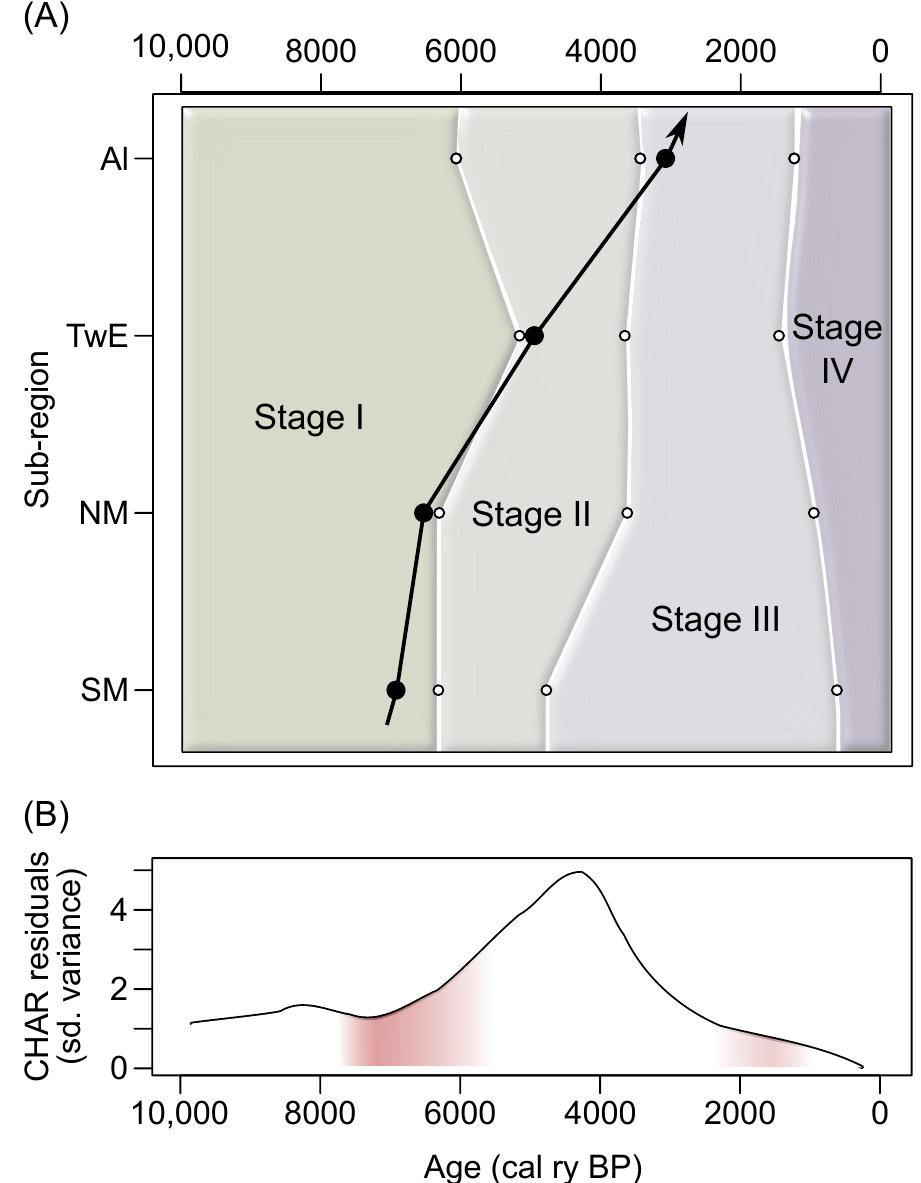
Figure 7. ( A ) Stages of socio-environmental development. The black line depicts the onset of pronounced forest loss identified at each sub-region through the Cross-Entropy method for break-point detection. Note the south-to-north time-transgressive pattern of deforestation. ( B ) Standardized variance of the residuals of the GAM employed in the detection of temporal trends in charcoal. The values are interpreted as a measure of spatial variability in fire activity, with low (high) values suggesting homogeneous (heterogeneous)